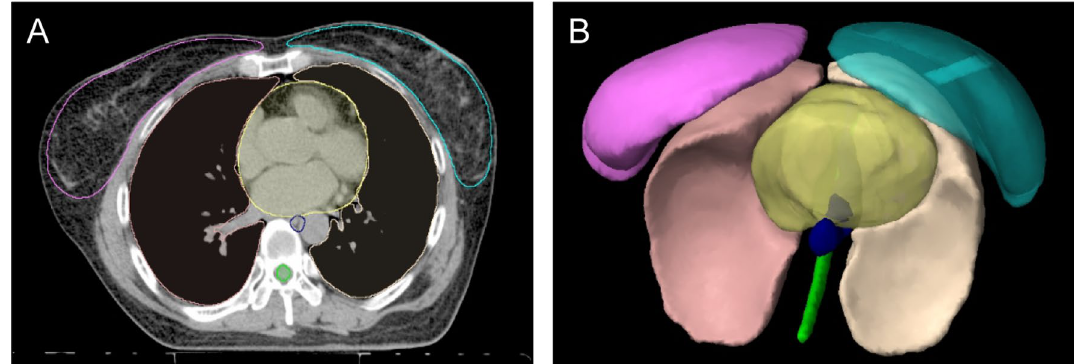
Figure 2. Autocontoured structures in the thorax (produced by Mirada RTx 1.8 and Workflow Box 1.4, Mirada Medical Ltd., Oxford, UK, https ://mirad a-medic al.com/radia tion-oncol ogy/) and 3-dimensional rendered images (produced by ECLIPSE™, version 10; Varian Medical Systems, Palo Alto, CA, USA, https ://www.varia n.com/produ cts/radio surge ry/treat ment-plann ing/eclip se). A: Autocontoured structures in the thorax area, B: 3-dimensional rendered